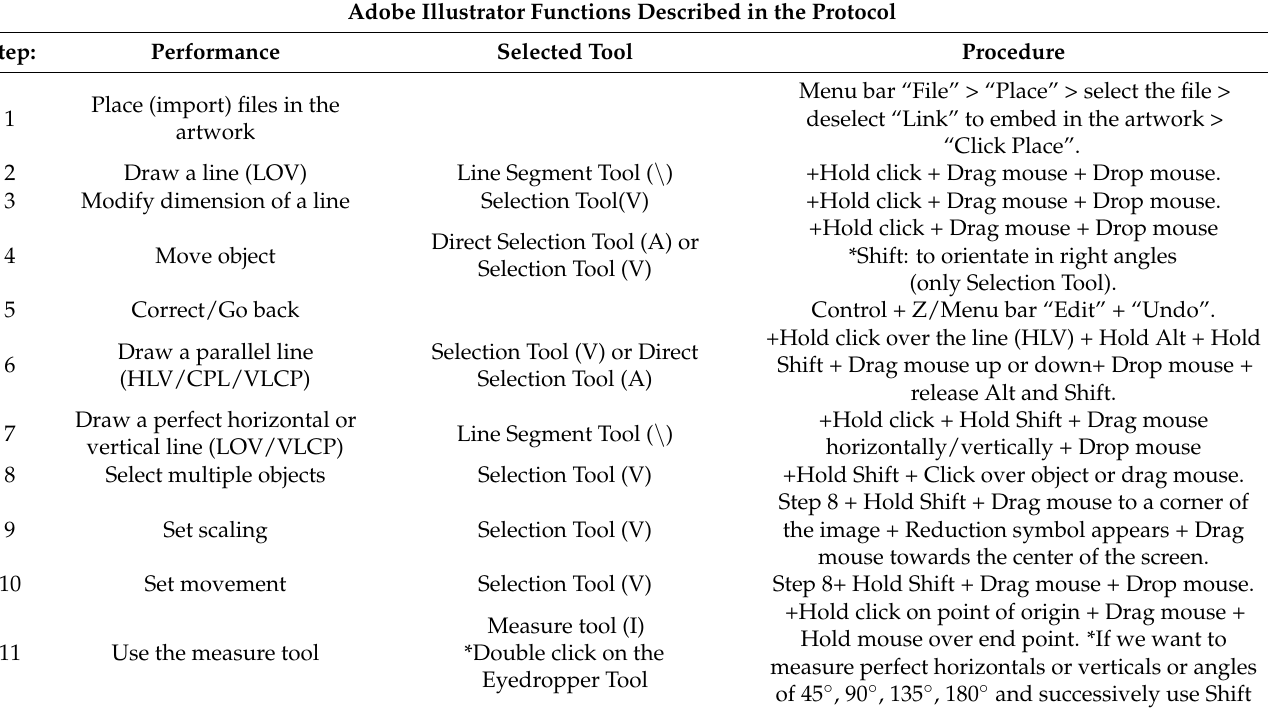
Table 1. Adobe Illustrator functions described in the protocol. LOV: line on the verifying witness. HLV: horizontal line on the verifying witness. CPL: calibrated parallel horizontal line. VLVP: vertical line over contact point. Controls. (V): selection tool command. (A): direct selection tool command. ( \ ): line segment tool command. (I): measure tool or eyedropper